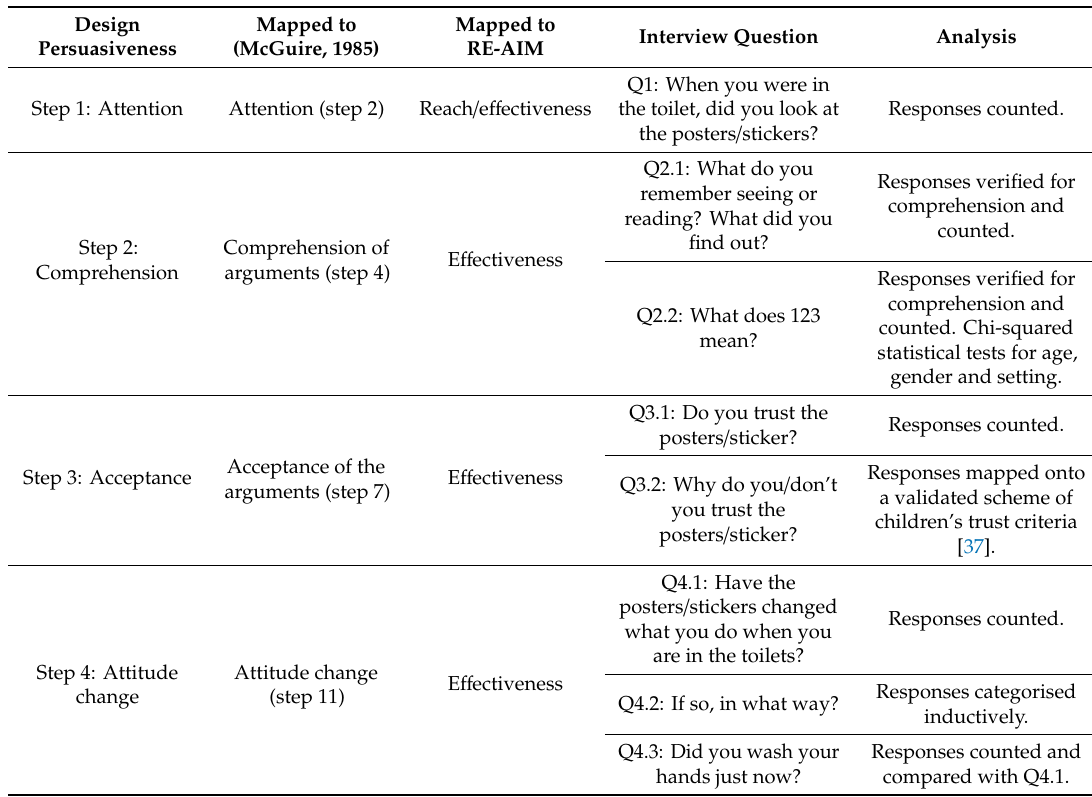
Table 7. Interview design and analysis.